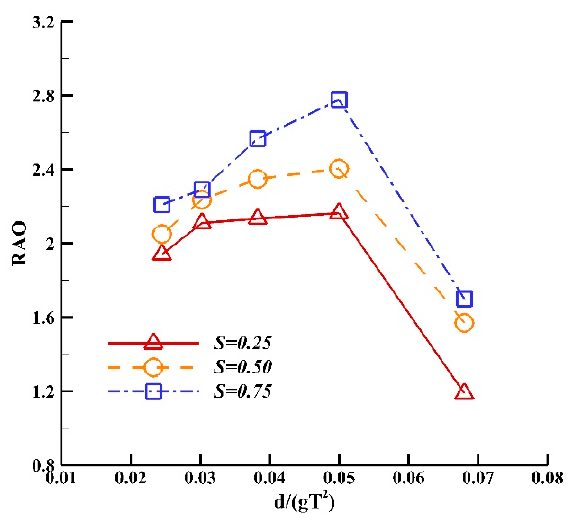
Figure 15. Effects of submerged depth on hydrodynamic performance of the buoy ( H = 0.1 m).